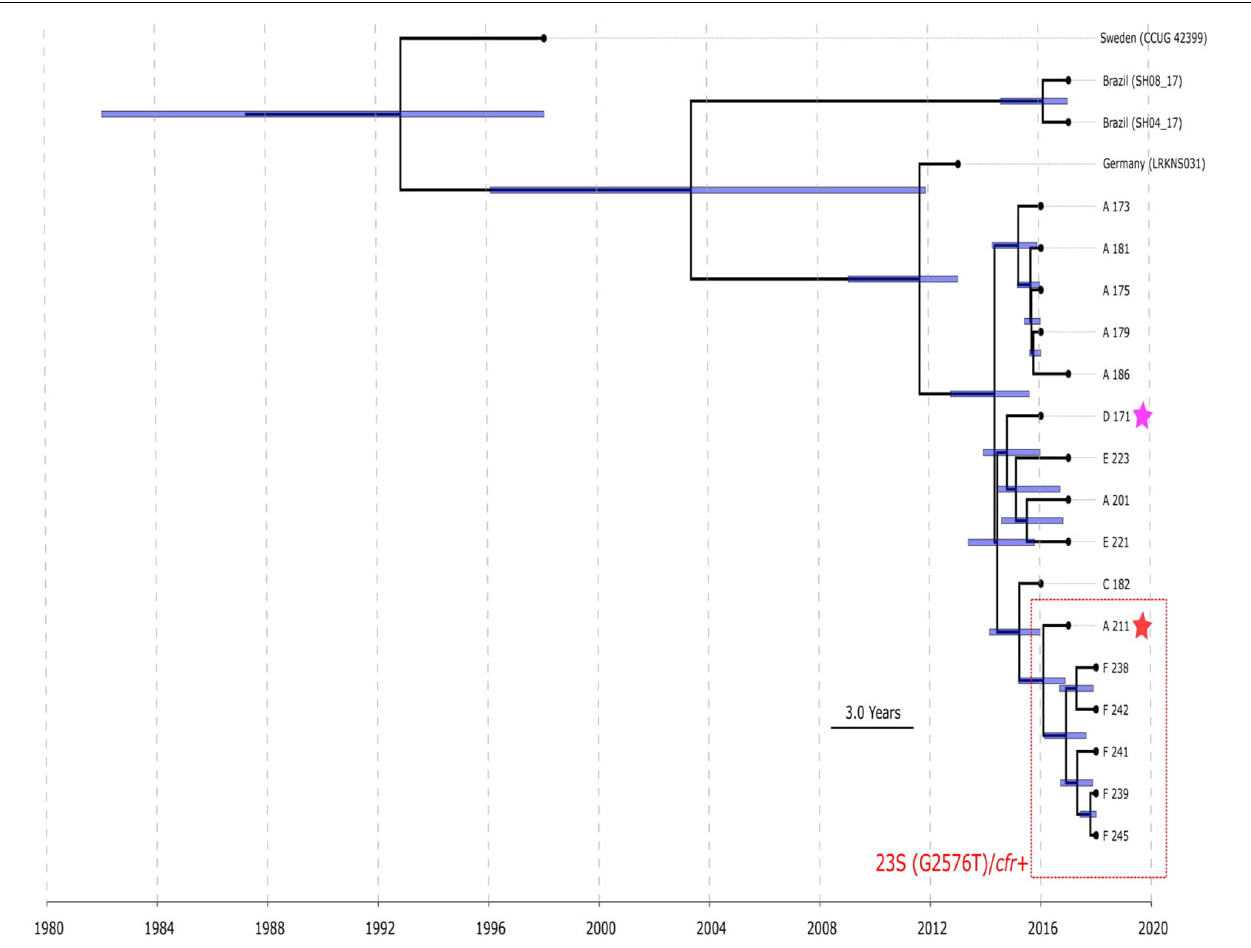
FIGURE 5 | Chronogram of S. hominis ST2 (BAPS cluster 6, n = 20) based on core-SNP alignment and BEAST. The violet star marks first time isolated oxazolidinone-resistant S. hominis in Russia, red star—first isolated cfr-positive S. hominis . Sites of appearance oxazolidinone-resistant S. hominis is shown on the figure (A, C–F). In addition to Russian isolates, this cluster included (blue names of strains): isolate LRKNS031 (linezolid-resistant S. hominis from Germany, BioProject PRJNA314440), two isolates from Brazil (BioProject PRJNA419707 and BioProject PRJNA419709) and linezolid-susceptible isolate CCUG 42399 from Sweden. 95% CI of time appearance (blue bars) shown near the